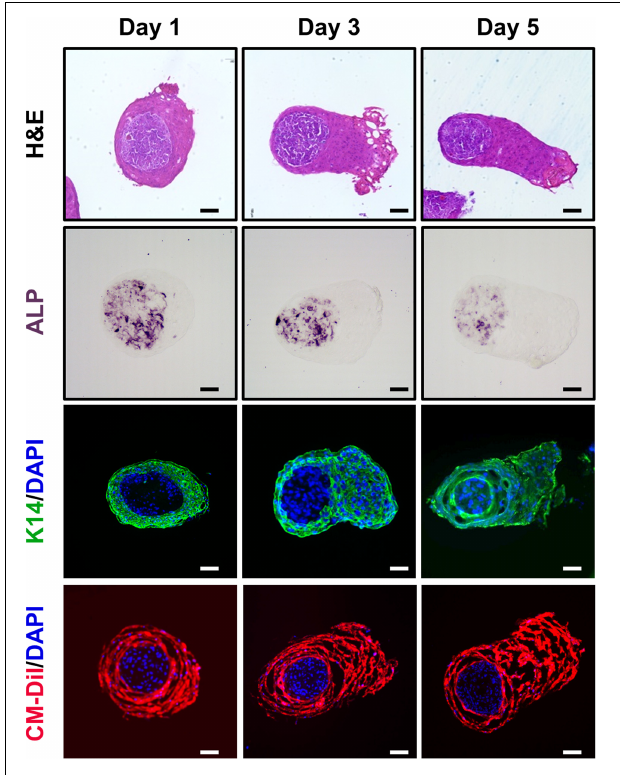
FIGURE 2 | Histological characterizations of the “two-cell assemblage (TCA)” structure. Microscopic images of the TCA were visualized at days 1, 3, and 5 of culture, using hematoxylin and eosin stain, immunohistochemical stain (alkaline phosphatase, ALP), or immunofluorescence stain (keratin 14, K14; cell-labeling dye, CM-Dil). Bar: 100 µ